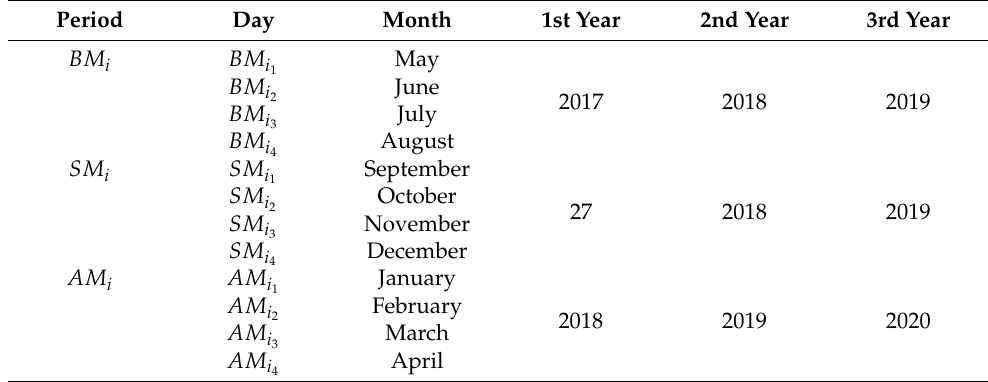
Table 12. The months for each